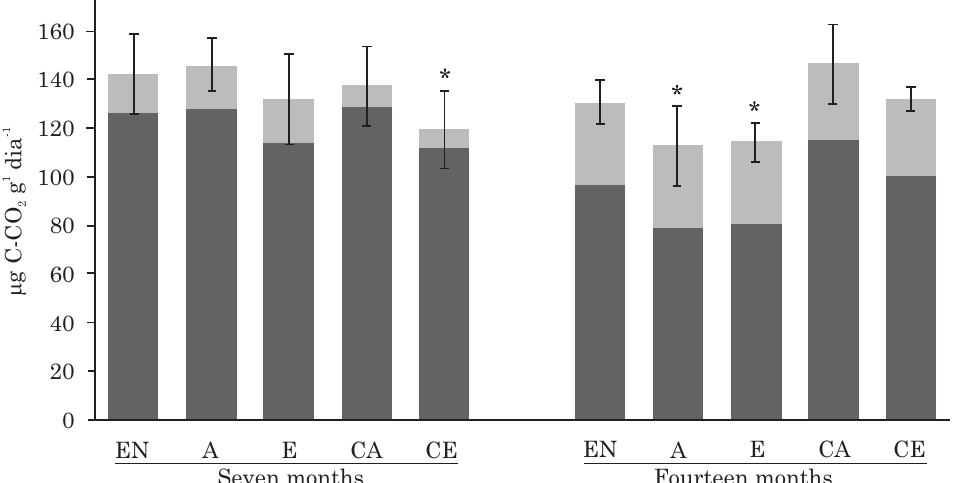
Figure 1. Daily CO 2 release by microbial respiration from the two compartments of the study: litter (dark gray) and soils (light gray), seven and 14 months after planting. (A) A. mangium monoculture; (E) E. grandis monoculture; (EN) E. grandis monoculture with N fertilizer; (CA) mixed plantation (measured at the stem base of A. mangium ); (CE) mixed plantation (measured at the stem base of E. grandis ). (*) indicate a statistical difference from the EN treatment according to Duncan’s test at a 5 %.